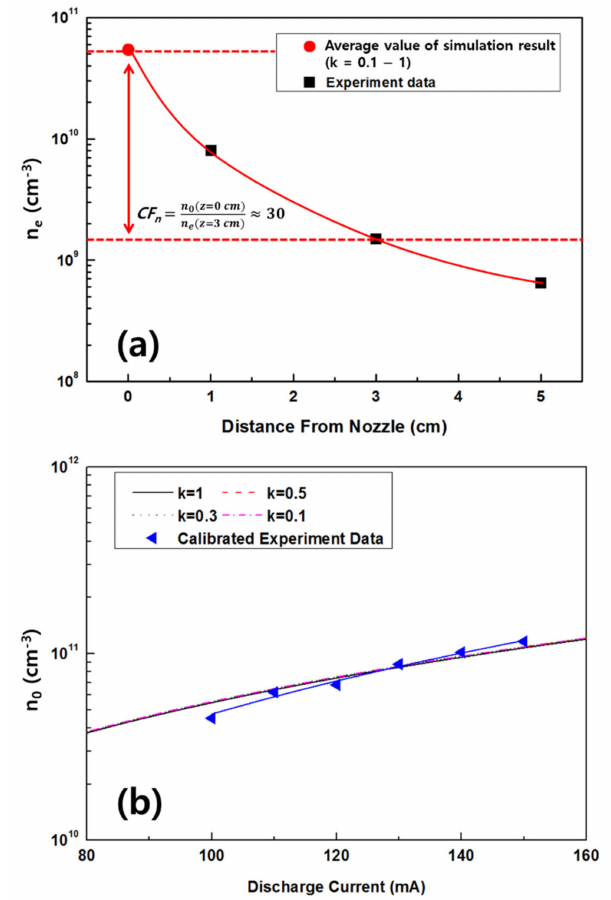
Figure 8. ( a ) The n e profiles according to distance from nozzle (argon gas flow rate: 75 sccm) to calibrate position difference for correct comparison of numerical calculation results with experiment data and ( b ) comparison of numerical calculation results with calibrated experiment data as a function of discharge currents at the same position (Z: 0 cm, argon gas flow rate: 75 sccm).